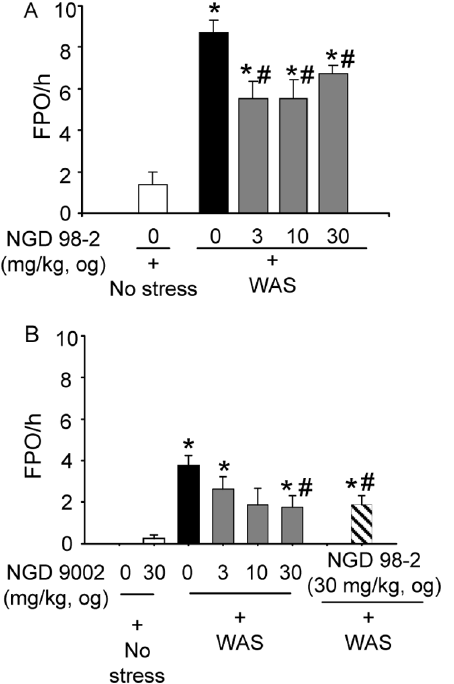
Figure 5. Oro-gastric (og) administration of NGD CRF 1 antagonist, NGD 98-2 or NGD 9002 reduces acute water avoidance stress (WAS)-induced stimulation of colonic propul- sive motor function in rats. Vehicle or NGD 98-2 (A) or NGD 9002 (B) at 3, 10 and 30 mg/kg was administered po and 180 min later (for NGD 98-2 group) or 60 min later (for NGD 9002 group), rats were exposed to WAS for 60 min. FPO was monitored during the 60 min stress session. Each bar represents the mean and SEM of 8 rats/group. *p , 0.05 compared with vehicle og + no stress; # p , 0.05 compared with vehicle og + WAS, ANOVA,